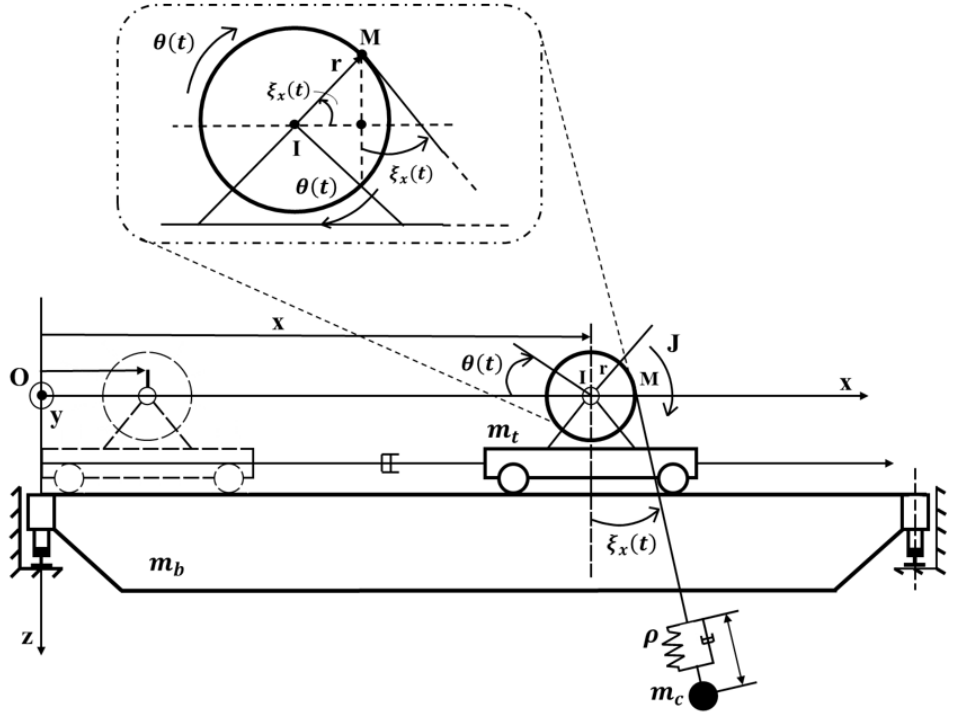
Figure 1. A digram of a 3D overhead crane model presented in the xyz